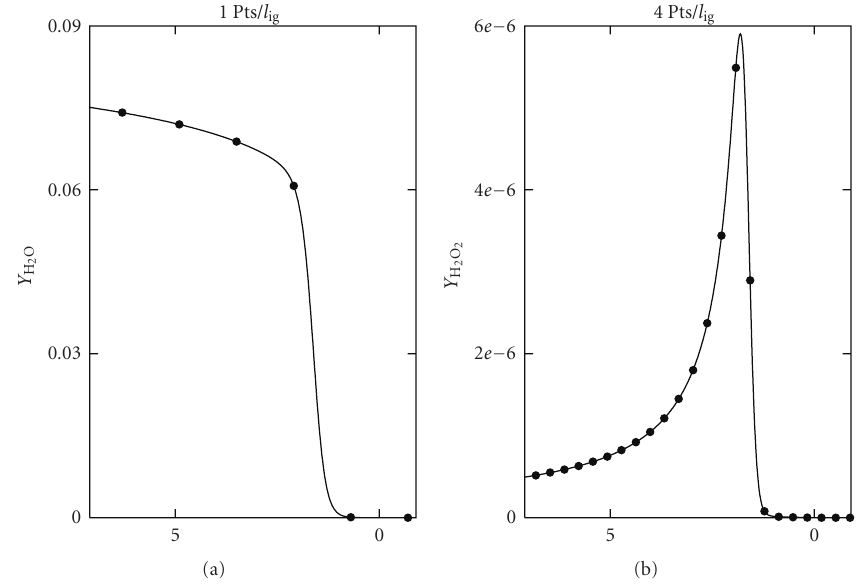
Figure 6: Representation of two mass fraction distributions on grids with di ff erent mesh widths for the detonation shown in Figure 1. The dots represent the values in the center of a finite volume. The abscissas show the distance behind the detonation front in mm.